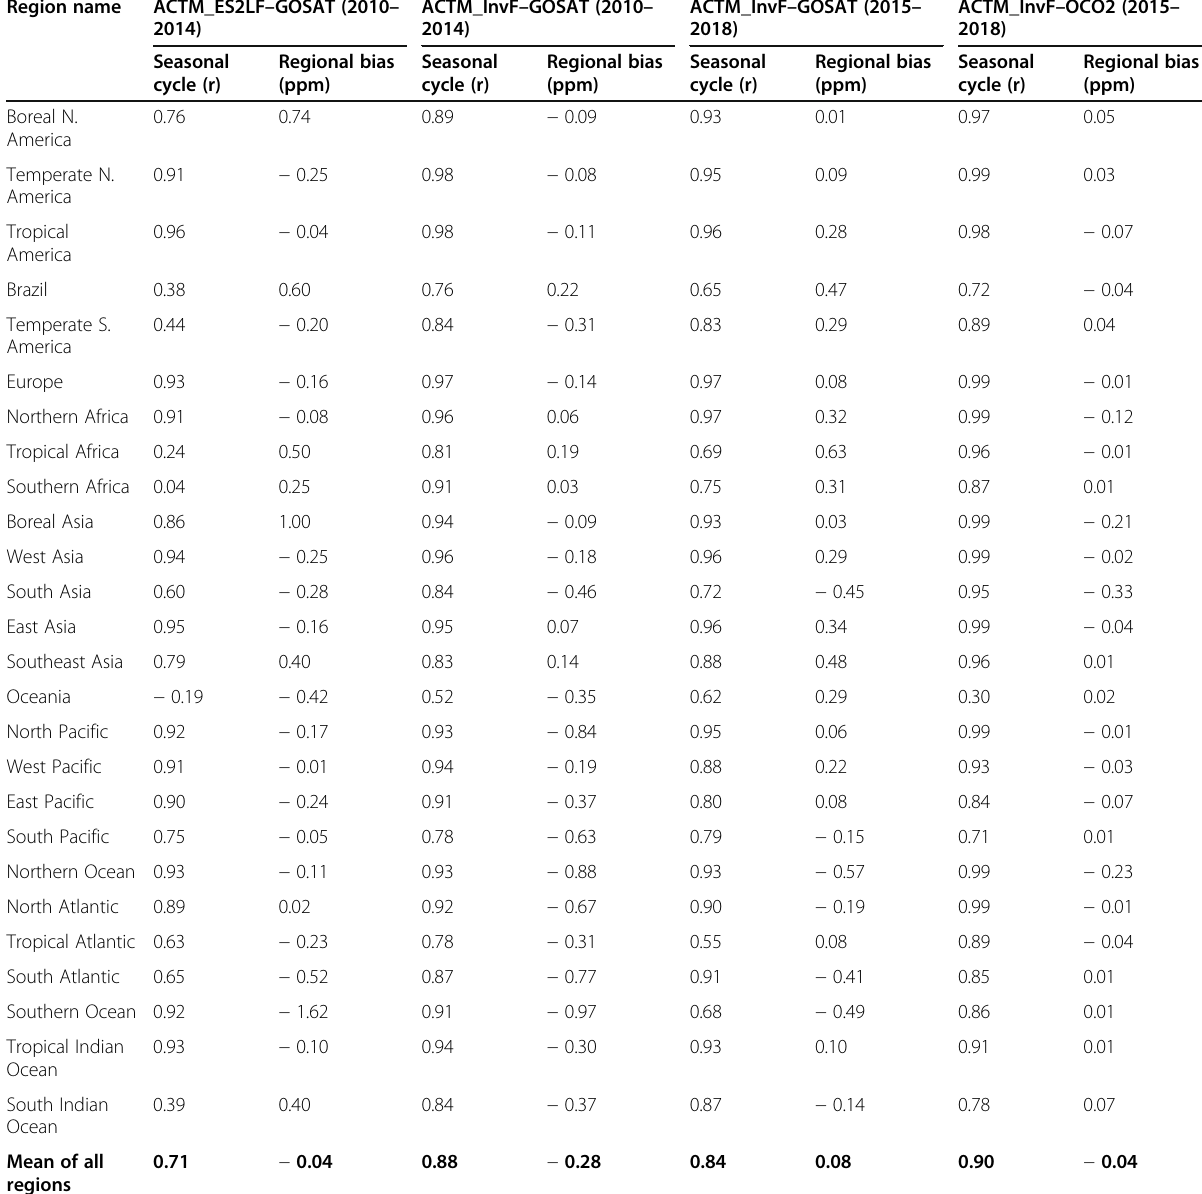
Table 1 Statistics of XCO 2 time series simulations in comparison with GOSAT and OCO-2 measurements. Correlation coefficients are calculated for the mean seasonal cycles of the time series as calculated by harmonic analysis. Mean XCO 2 biases are calculated as the differences for the overlapping periods between two data records. The regions are arranged from North to South latitudes within each of the continents and ocean basins, as much as